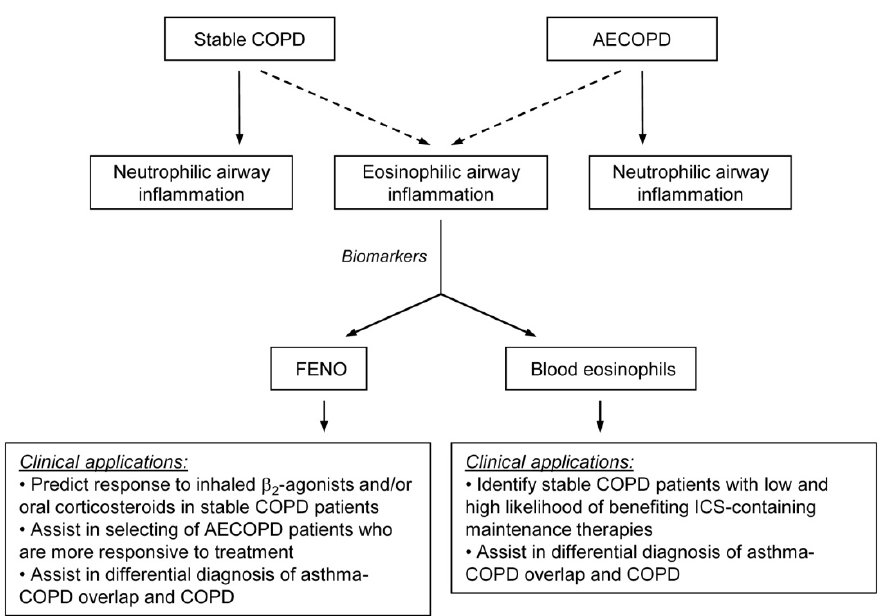
Figure 1. Schematic representation of the utility of fractional exhaled nitric oxide (FENO) levels and peripheral blood eosinophil counts as surrogate biomarkers for assessing eosinophilic airway inflammation in stable COPD and acute exacerbations (AECOPD). ICS: inhaled corticosteroid.